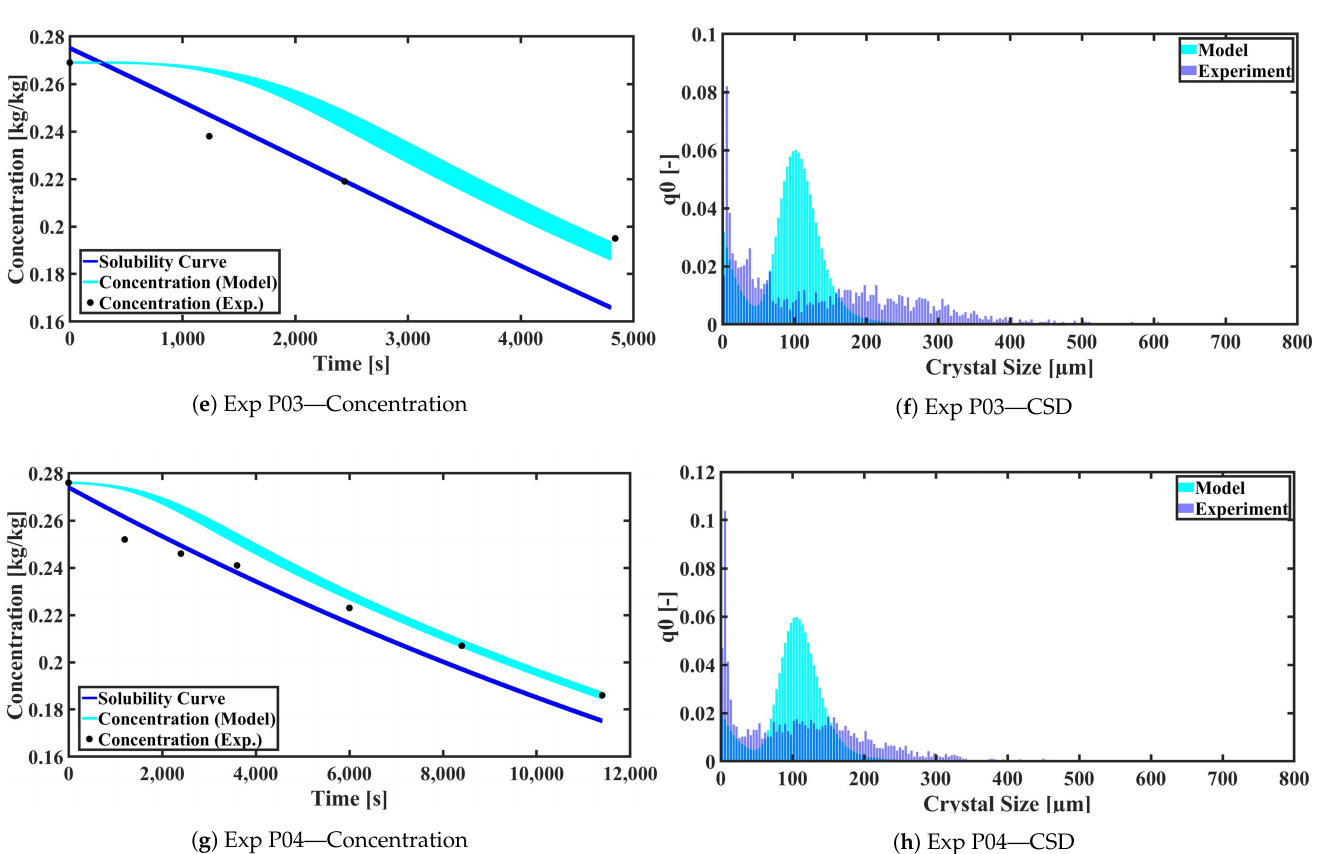
Figure 4. Comparison of the solute concentration profile and final crystal size distribution.